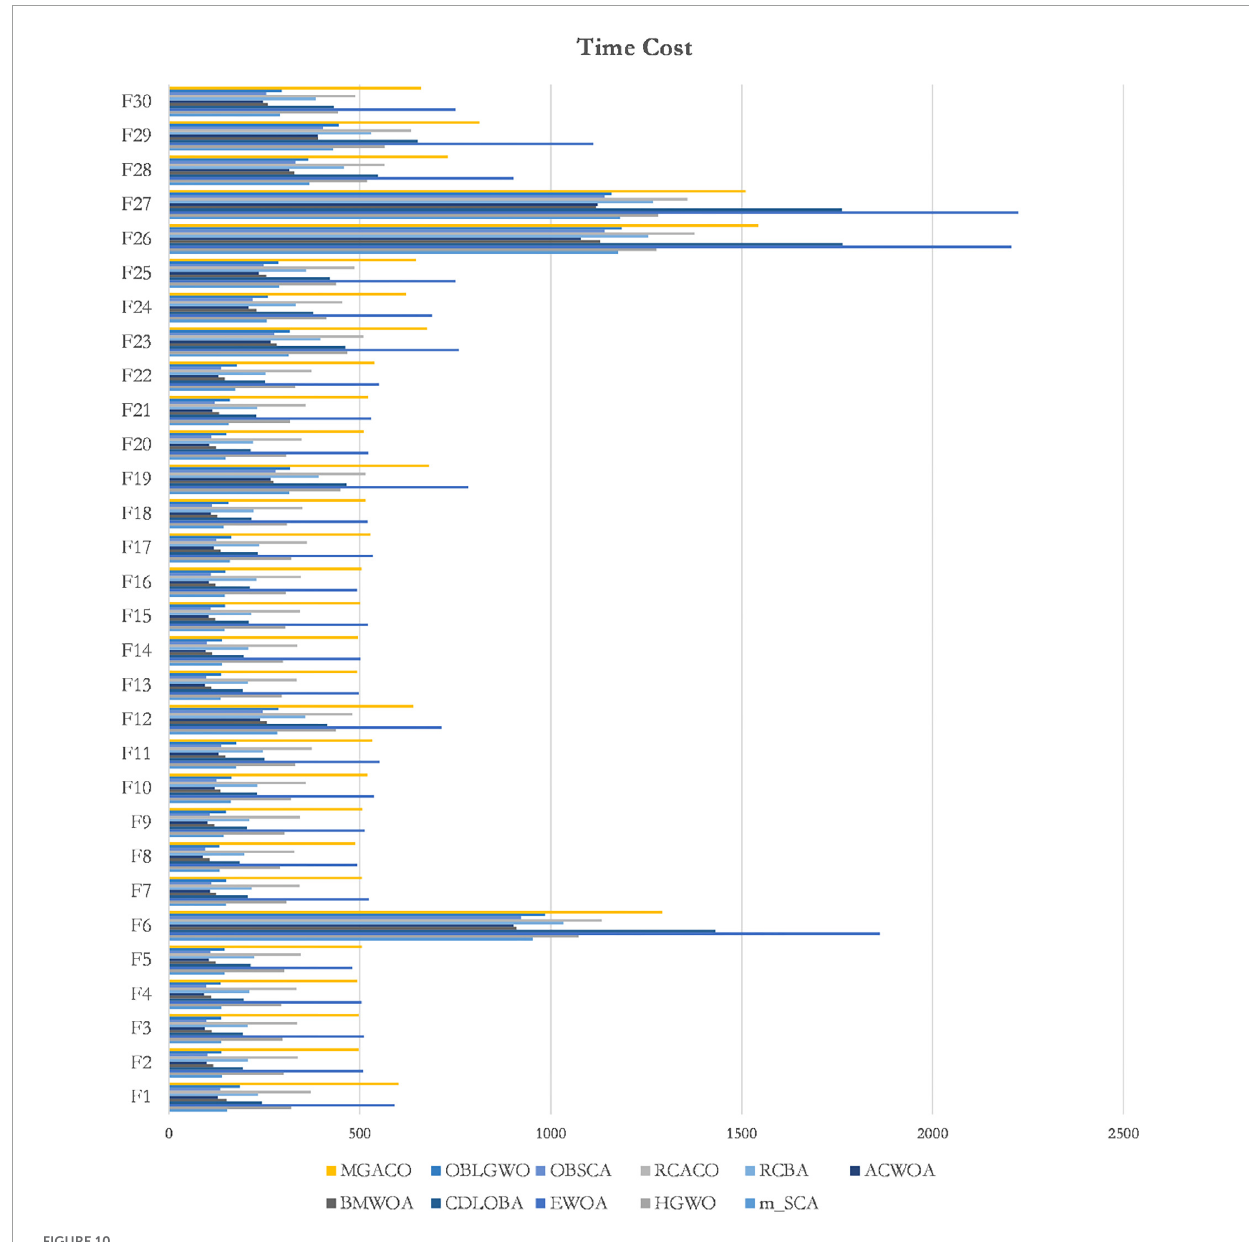
FIGURE10 The total CPU time consumption of all methods for 30 independent